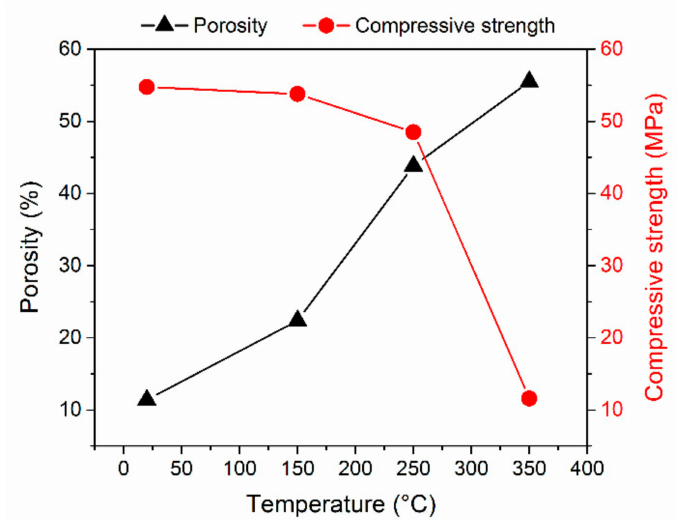
Figure 8. Porosity and compressive strength in dependence on temperature of exposure.